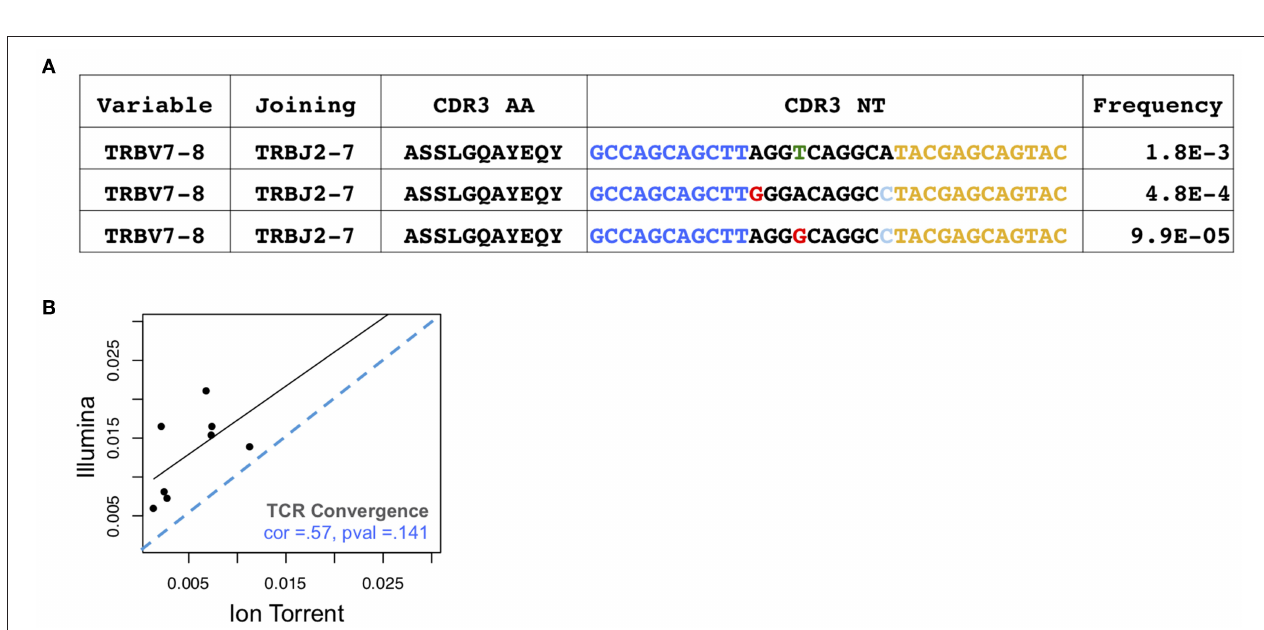
FIGURE 1 | Comparative analysis of repertoire features in samples analyzed via Ion Torrent and Illumina-based assays. Eight peripheral blood leukocyte (PBL) samples derived from three donors were analyzed using the Oncomine TCRB-LR assay (Ion Torrent, X-axis) or Sequenta TCRB assay (Illumina, Y-axis). Pearson’s correlation coefficient was used to measure the consistency of two platforms with respect to (A) clone diversity (Shannon entropy), (B) clonality (normalized Shannon entropy), and (C) clonal overlap. Blue dashes indicate position of identity line.